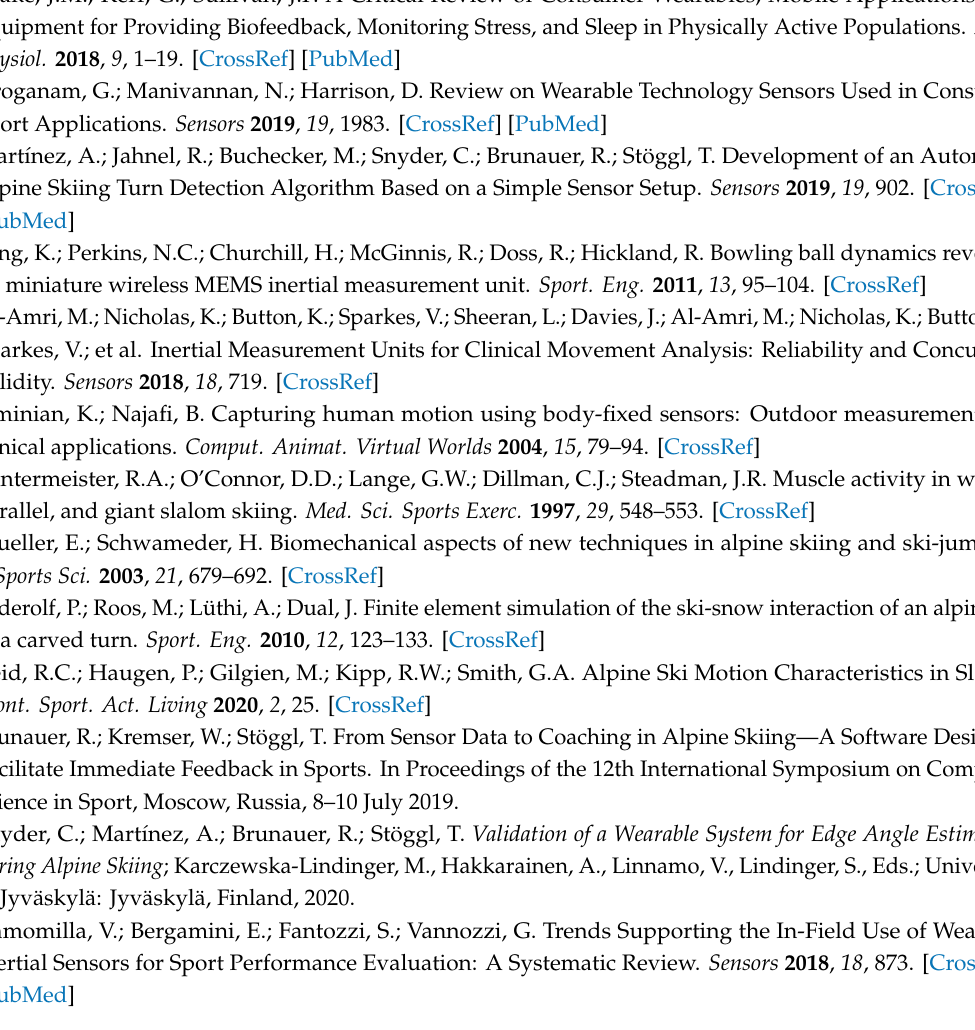
Figure A3. Decision tree for the classification of the non-parallel turns (mean_EA_Edge_AngleLeftRight = mean of the maximum estimated inclination angle of the left and right foot of turn, mean_ACC_X_filt = mean of the maximum of the acceleration of the X -axis of left and right foot of turn, Turn_DurationSec = duration of turn (in seconds)).